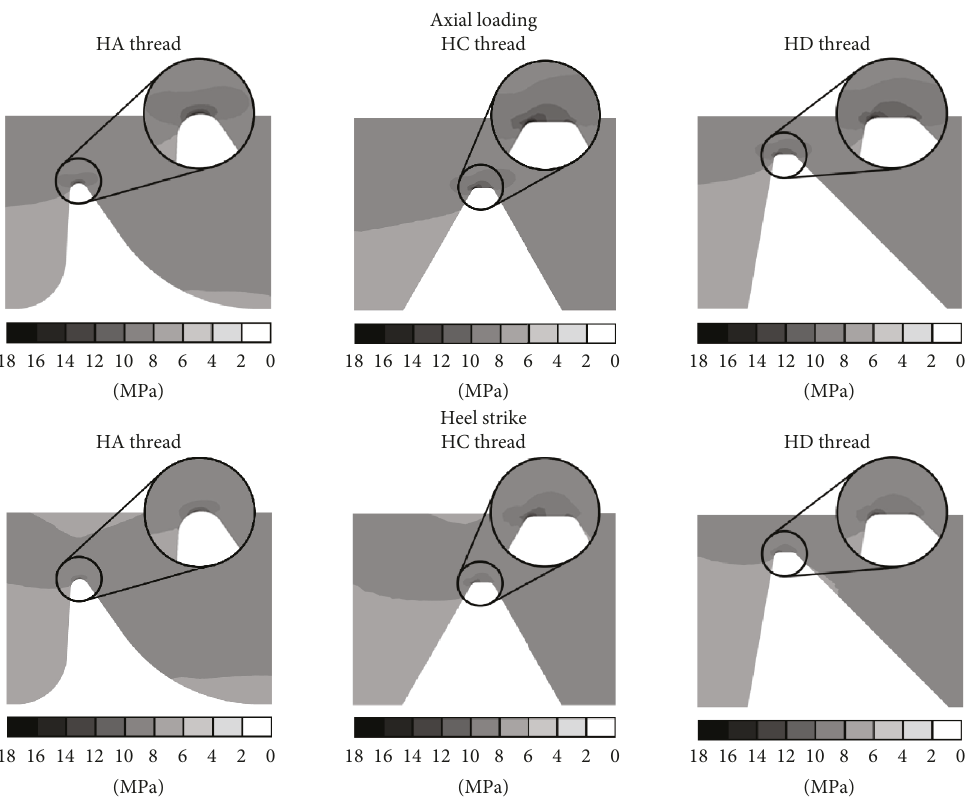
Figure 4: Equivalent stress patterns (MPa): cross section through stress peak location.